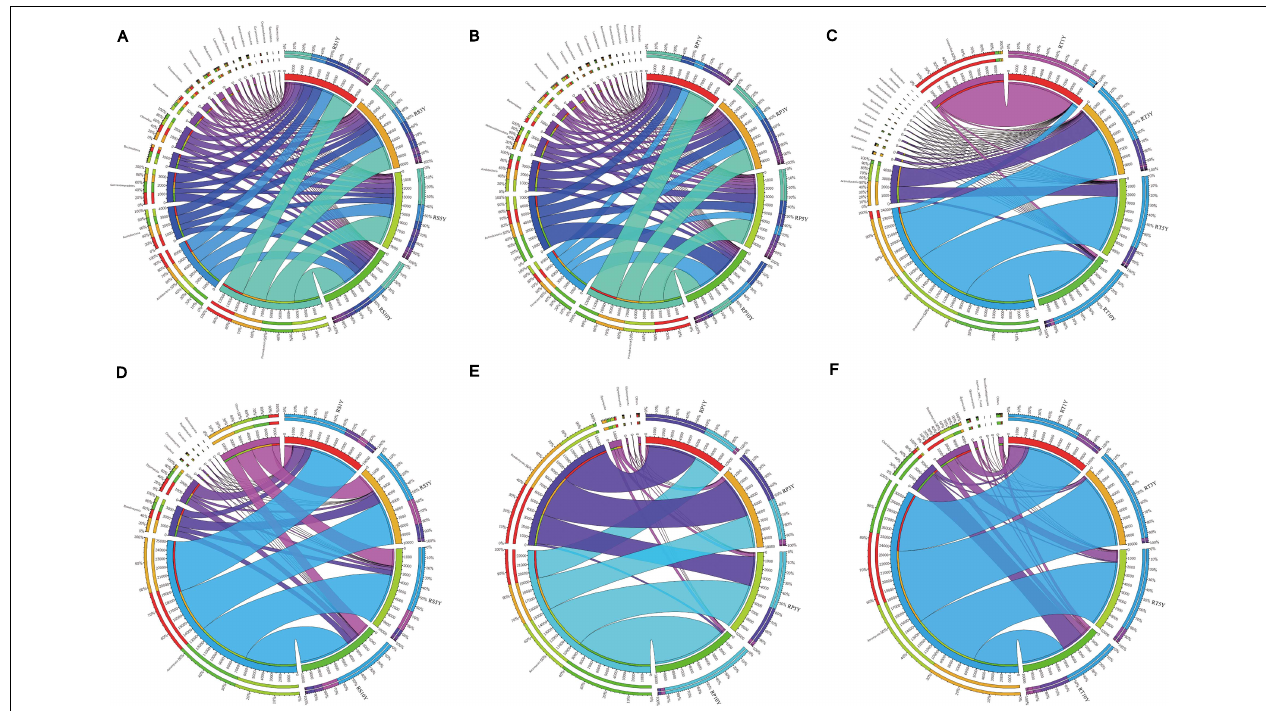
FIGURE 1 | Distribution of dominant (top 20) phyla in four different samples in three root-associated compartments. [ (A–C) represented the bacterial community in rhizosphere, rhizoplane, and root, respectively; (D–F) represented the fungal community in rhizosphere, rhizoplane, and endosphere, respectively]. The thickness of each ribbon represents the abundance of each taxon. The relative tick above the outer segment stands for the relative abundance of each taxon. The data were visualized using Circos (Version 0.69, http://circos.ca/).